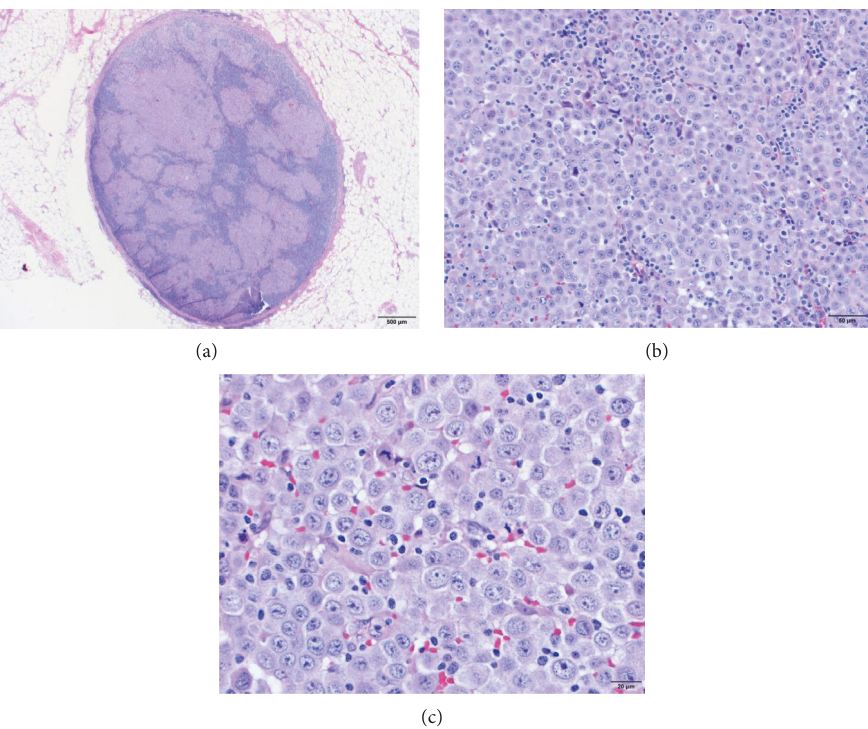
Figure 1: H&E sections of the biopsy specimen demonstrating an involved lymph node. Images (a), (b), and (c) are at 2x, 10x, and 40x magnifications, respectively. The tumor cells are large, monomorphic, immunoblast-like with oval nuclei, prominent nucleoli, and abundant cytoplasm. The background shows residual small